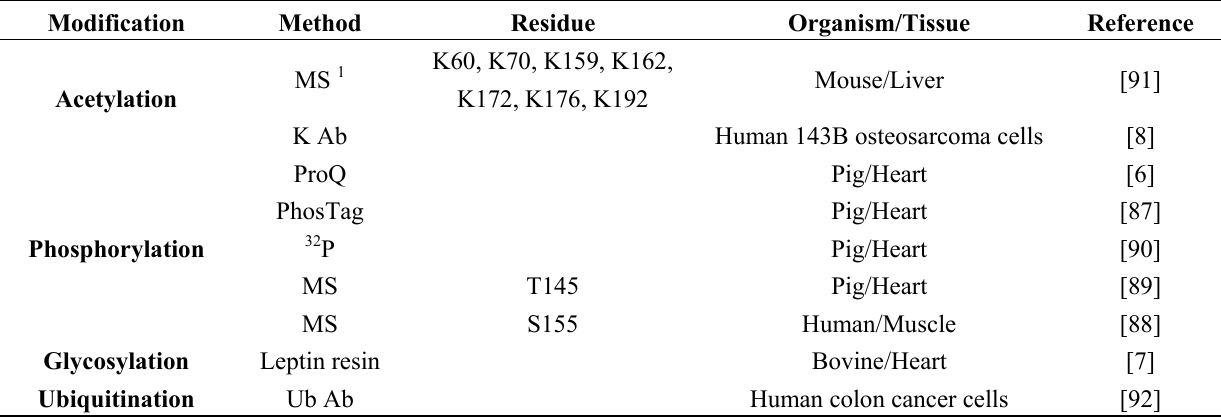
Table 2. Post-translational modifications of